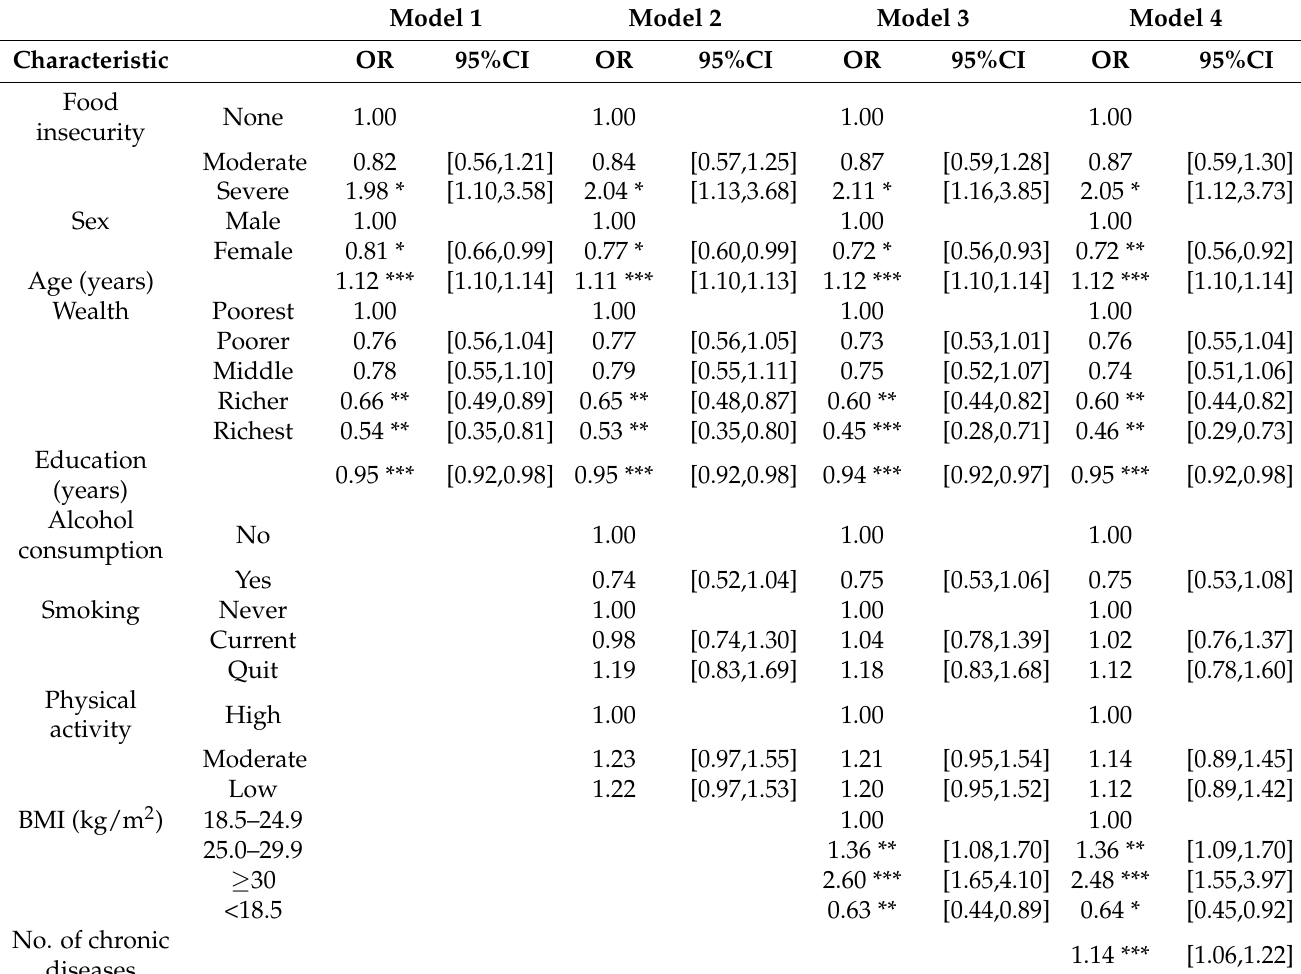
Table 2. Association between food insecurity and sarcopenia (outcome) estimated by multivariable logistic